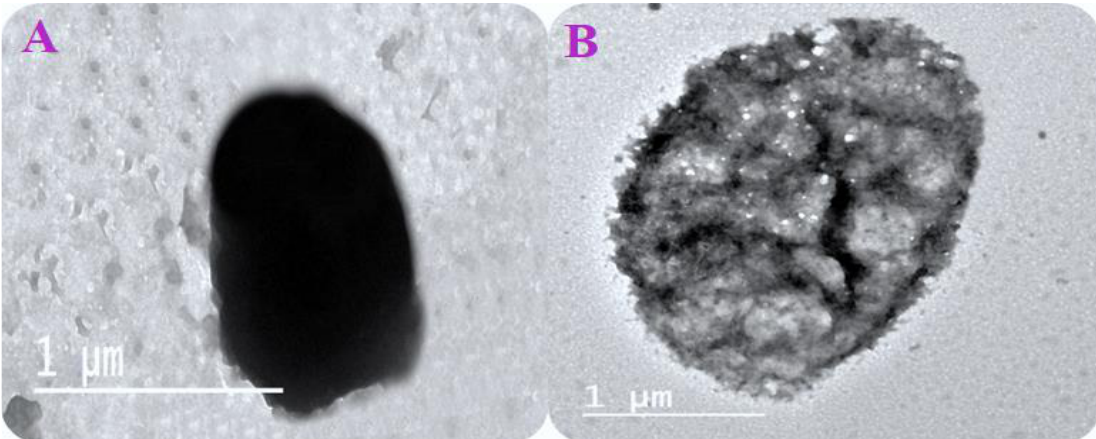
Figure 9. TEM images where ( A ) TEM native S. cerevisiae and ( B ) loading with lead.